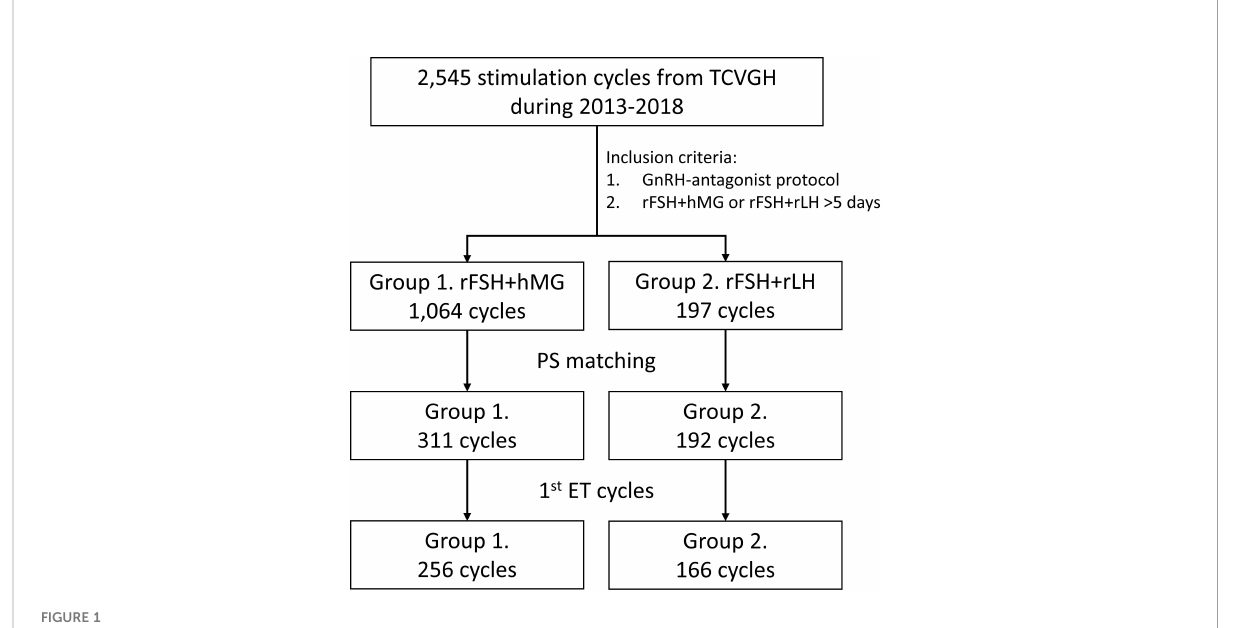
FIGURE 1 Flowchart of the study